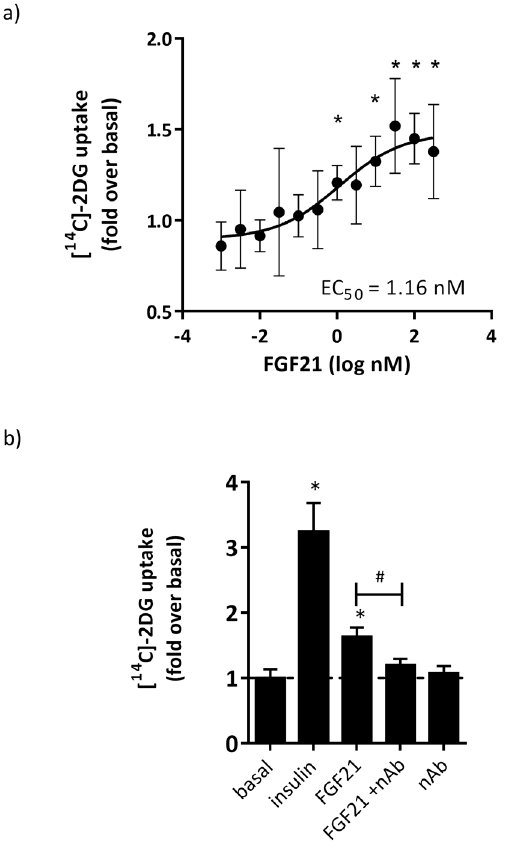
Figure 2. FGF21 modestly induced glucose uptake, which was inhibited by anti-FGF21 neutralizing antibody. hASC-adipocytes were treated with FGF21 for 30 minutes prior to the addition of [14C]- 2DG for 30 min. a) Dose dependent effects of FGF21 on glucose uptake. N=8 wells + S.D.; EC50 of 1.16 nM and max induction of 65% above basal signal. b) Effects of a FGF21 neutralizing antibody on the FGF21- dependent effects on glucose uptake. N=6 wells + S.D.; induction with 32 nM FGF21 at 63% above basal, which is significantly inhibited by co- treatment with 100 ug/ml anti-FGF21 neutralizing antibody (nAb) ( # p , 0.05). * p , 0.05 vs